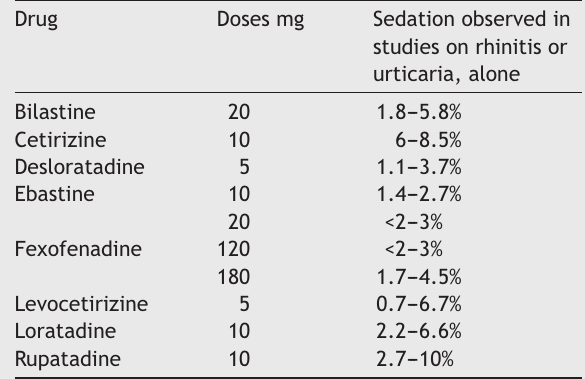
Second-generation antihistamines and effects on the central nervous system.